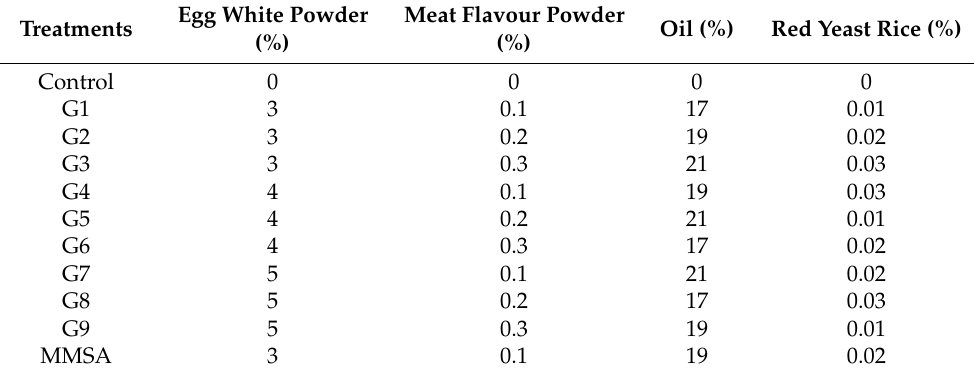
Table 1. Key factorial design for mushroom-based meat sausage analogues formulation. Egg White Powder Meat Flavour Powder Treatments Oil (%) Red Yeast Rice (%) (%)